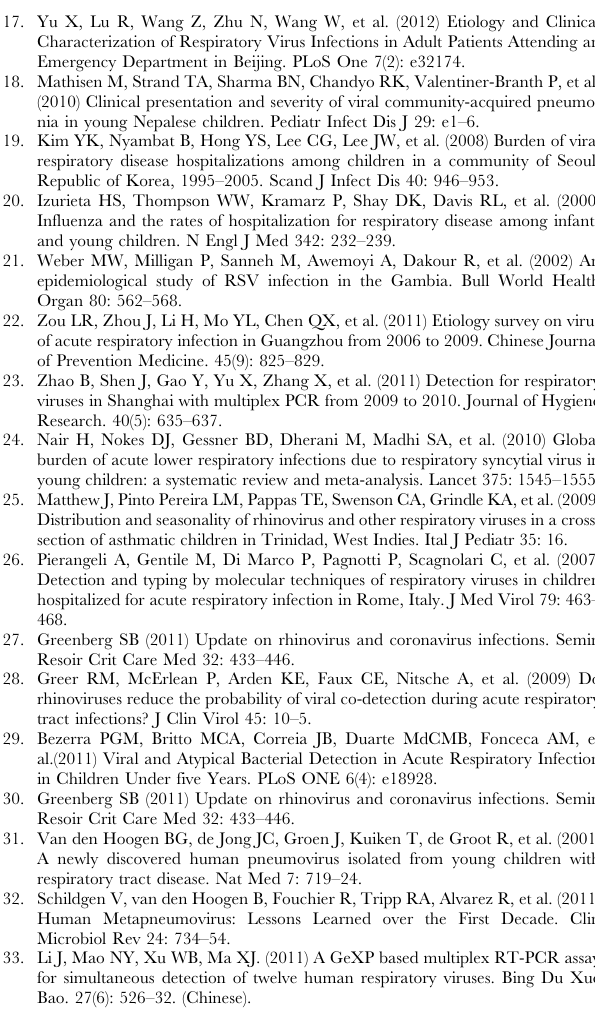
Table 4. The detection of 16 respiratory viral pathogens was done in two groups: Group A was tested for the presence of FluA, FluB, sH1N1, HRV, CoV 229E/CoV OC43/CoV HKU1, PIV1, and HAdV; Group B was tested for the presence of RSVA/B, CoV NL63, PIV2/PIV3, HMPV and BoCA.